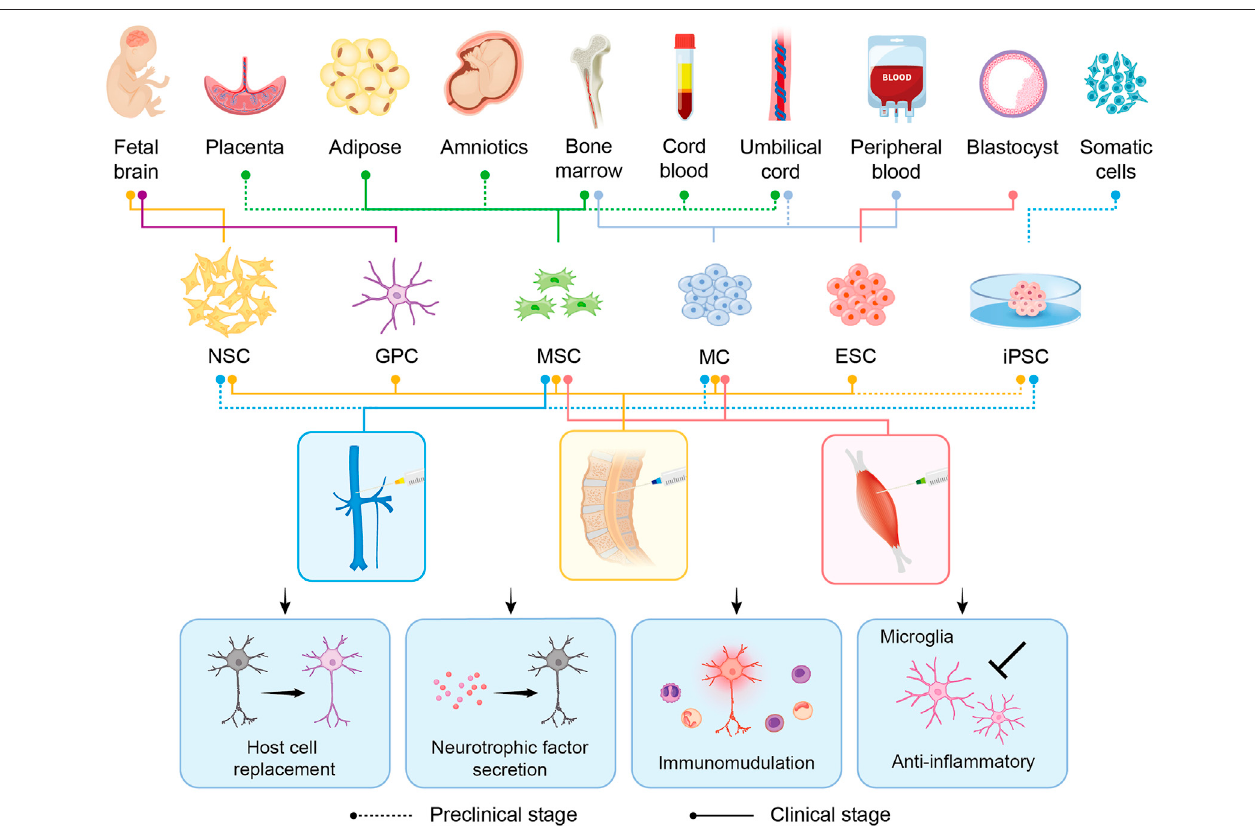
FIGURE 2| Overview of the derivations, interventionmethods, and therapeutic bene fi ts ofstemcell transplantation in preclinical/clinical studies related to ALS. Six majorcandidate celltypes (NSC, GPC, MSC, MC, ESC, and iPSC) arerepresented inthe schematic. Different derivations and intervention methods ofeach cell type are indicated by lines of different colors and types. The type of line, dotted or solid, shows the hierarchy, representing the application in preclinical studies alone or in the clinical stage already. In the middle panel, blue, yellow, and red represent intravenous, intrathecal, and intramuscular injection, respectively. The transplanted cells exerttheirtherapeuticbene fi tsthroughhostcellreplacement,neurotrophicfactorsecretion,immunomodulation,andanti-in fl ammatory.NSC:neuralstemcell;GPC:glial progenitor cell; MSC: mesenchymal stem cell; MC: mononuclear cell; ESC: embryonic stem cell; iPSC: induced-pluripotent stem cell.